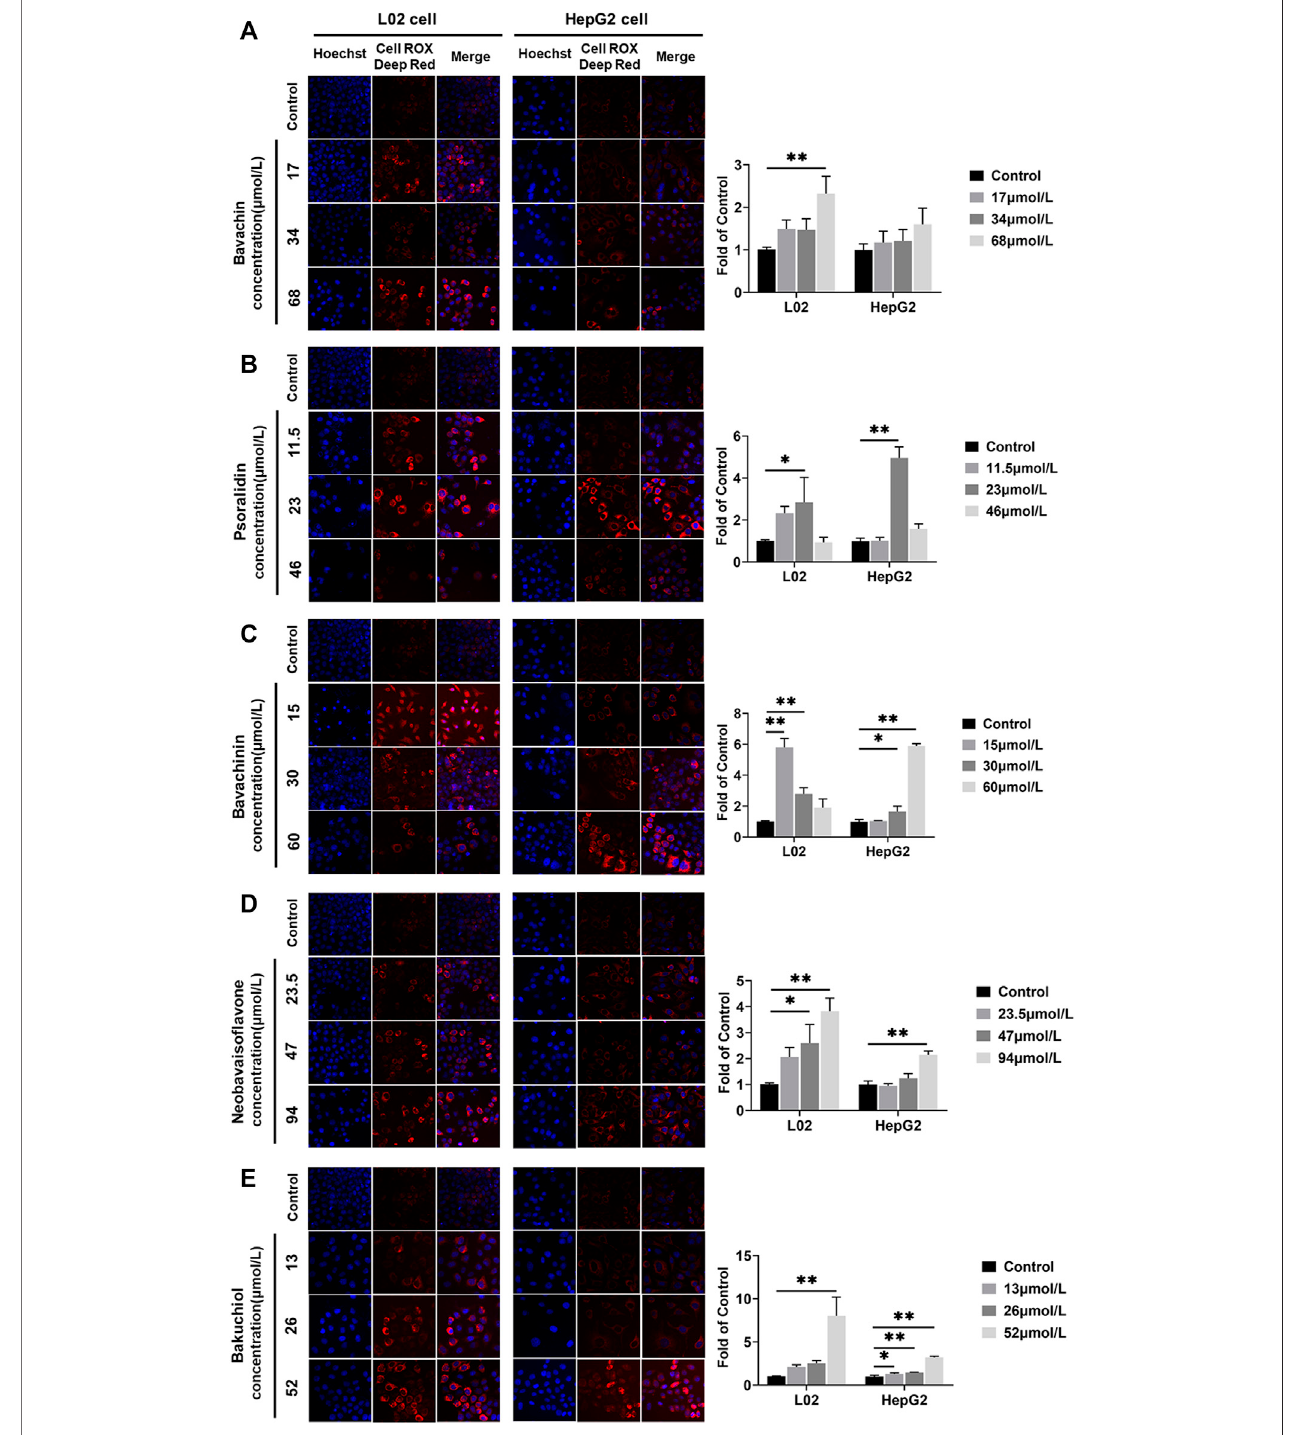
FIGURE 9 | ROS was examined and quanti fi ed using the CellROX Deep Red Reagent staining assays after the fi ve compounds were exposed in L02 and HepG2 cells. (A) Bavachin; (B) psoralidin; (C) bavachinin; (D) neobavaiso fl avone; (E) bakuchiol. Values are presented as mean ± SD, n (cid:1) 3. * p < 0.05, ** p < 0.01 versus the control group. ROS, reactive oxygen species.